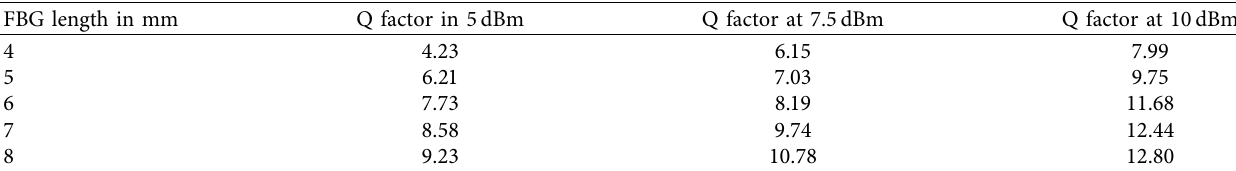
Table 6: Q-factor results for 4 FBG+DCF linear Gaussian apodization simulation models. FBG length in mm Q factor in 5dBm Q factor at